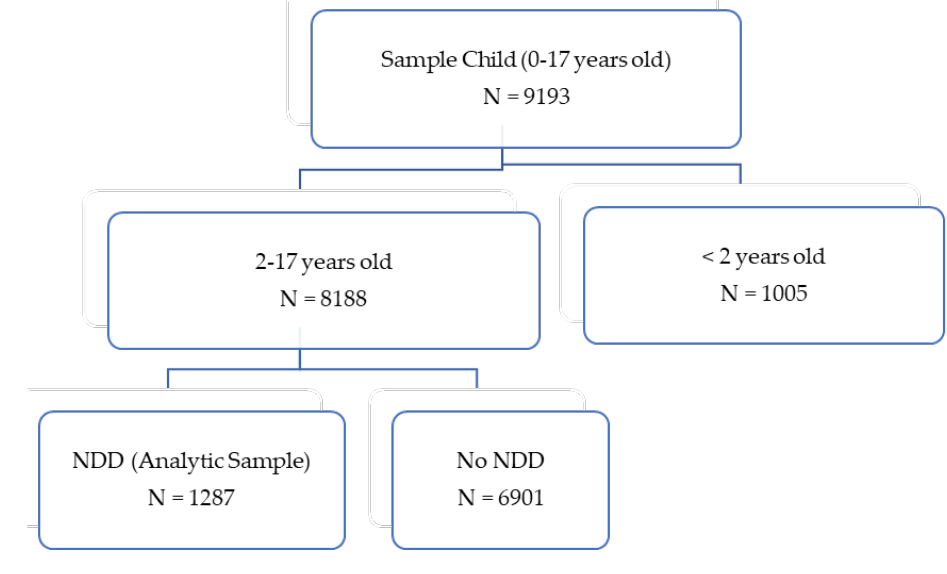
Figure 1. Final Analytic Sample.